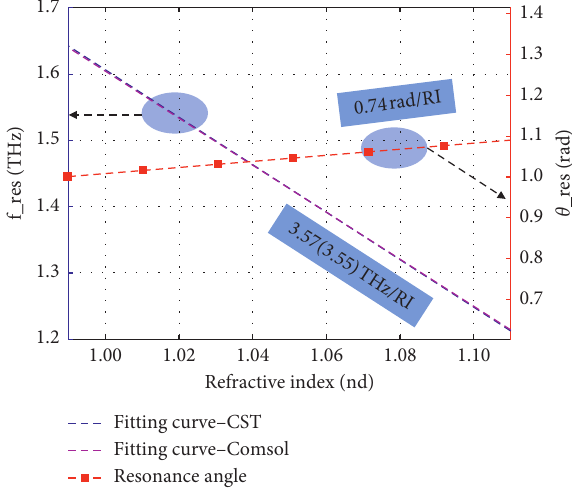
Figure 7: Fitting curve of resonance frequency and resonance angle and refractive